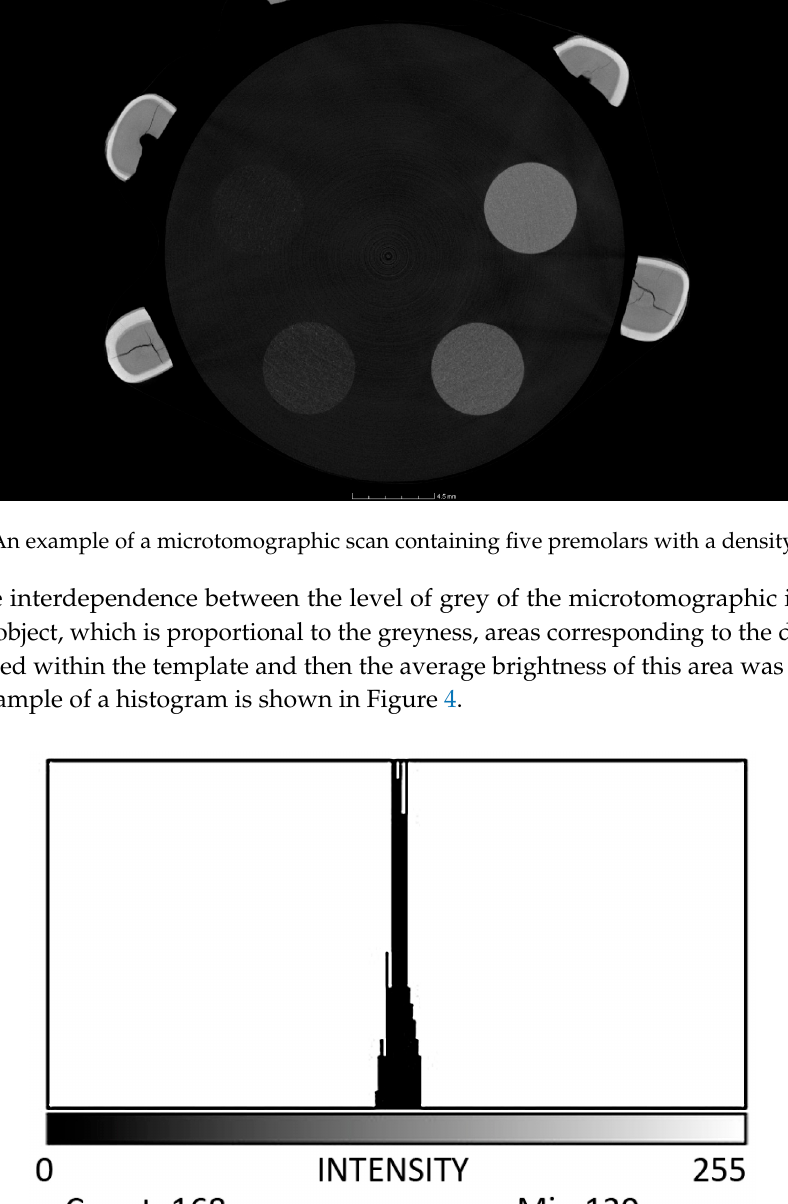
Figure 4. Sample histogram obtained from ImageJ determining the average brightness of dentin.